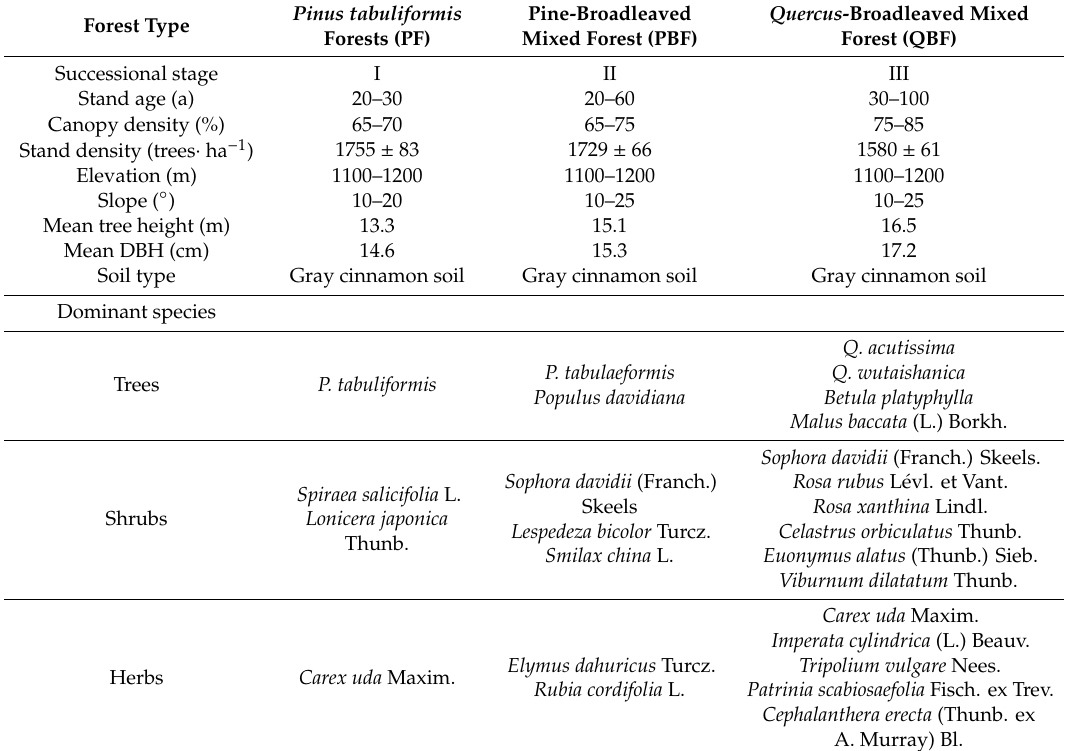
Table 1. Stand characteristics of the three succession stages in the Huanglong-Qiaoshan forest